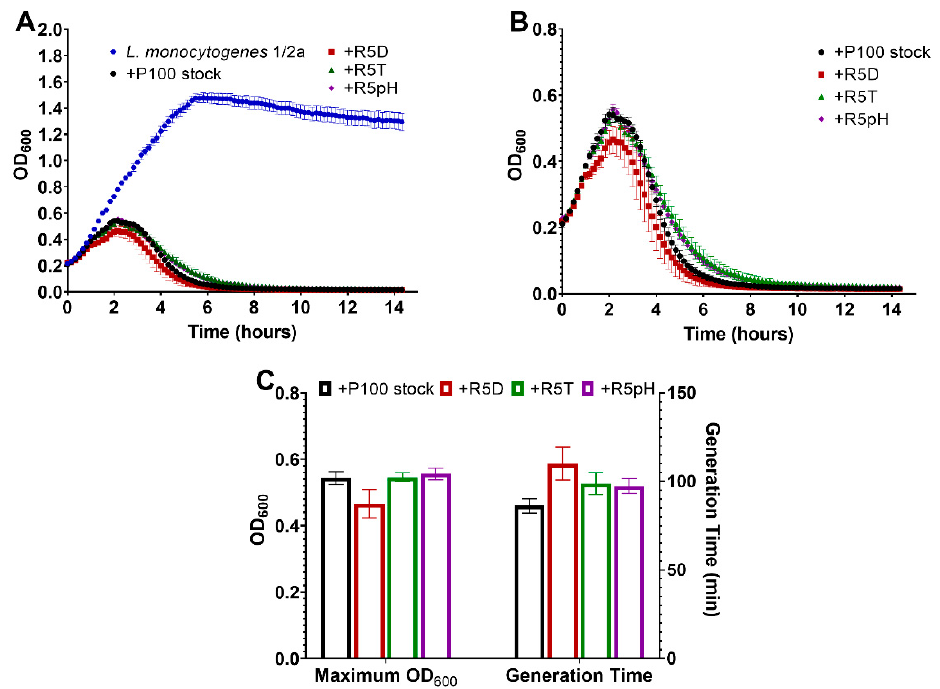
Figure 5. ( A ) Growth curve of a L. monocytogenes serotype 1/2a sample left uninfected as compared to infection with P100 stock and reversion-tested P100 samples selected for resistance to desiccation (R5D), resistance to high-temperature exposure (R5T), and resistance to low-pH exposure (R5pH). ( B ) Same growth curve of an L. monocytogenes serotype 1/2a sample infected with P100 stock and reversion-tested P100 samples R5D, R5T, R5pH shown at a higher OD 600 resolution to compare the different growth curve trends. ( C ) Maximum OD 600 reading and generation time (minutes) for L. monocytogenes serotype 1/2a samples infected with different P100 bacteriophage samples. Three biological replicates were tested for the different engineered P100 samples, with all experiments being performed in triplicate. Results are shown as average of the biological replicates ± standard deviation for the reversion-tested phage and the average of the technical replicates ± standard deviation for the P100 stock. Differences in maximum OD 600 and generation time between the P100 ancestral stock and the reversion-tested samples was determined to be statistically insignificant. Nomenclature: R5D: P100 that sample underwent 5 cycles of desiccation selection followed by 5 propagation cycles in the absence of stress; R5T: P100 sample that underwent 5 cycles of high-temperature selection followed by 5 propagation cycles in the absence of stress; R5pH: P100 sample that underwent 5 cycles of low-pH selection followed by 5 propagation cycles in the absence of